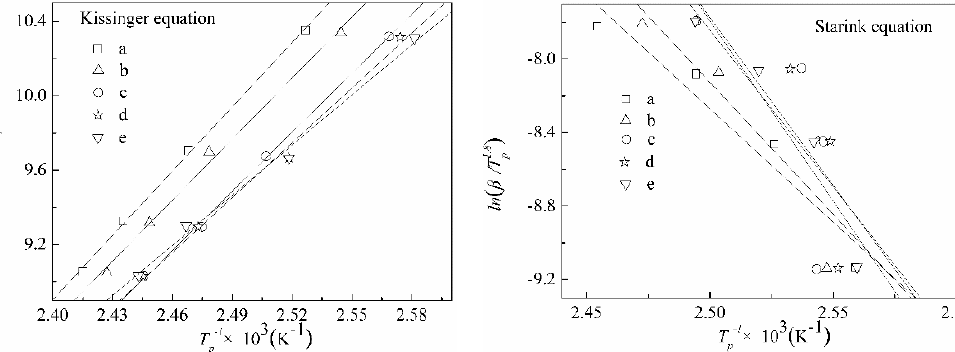
Figure 9. Linear fitting charts of − ln( β /T p 2 ) and − ln( β /T p 1.8 ) versus 1/ T p (( a ) 0%; ( b ) 5%; ( c ) 10%; ( d ) 15%; ( e ) 20%).